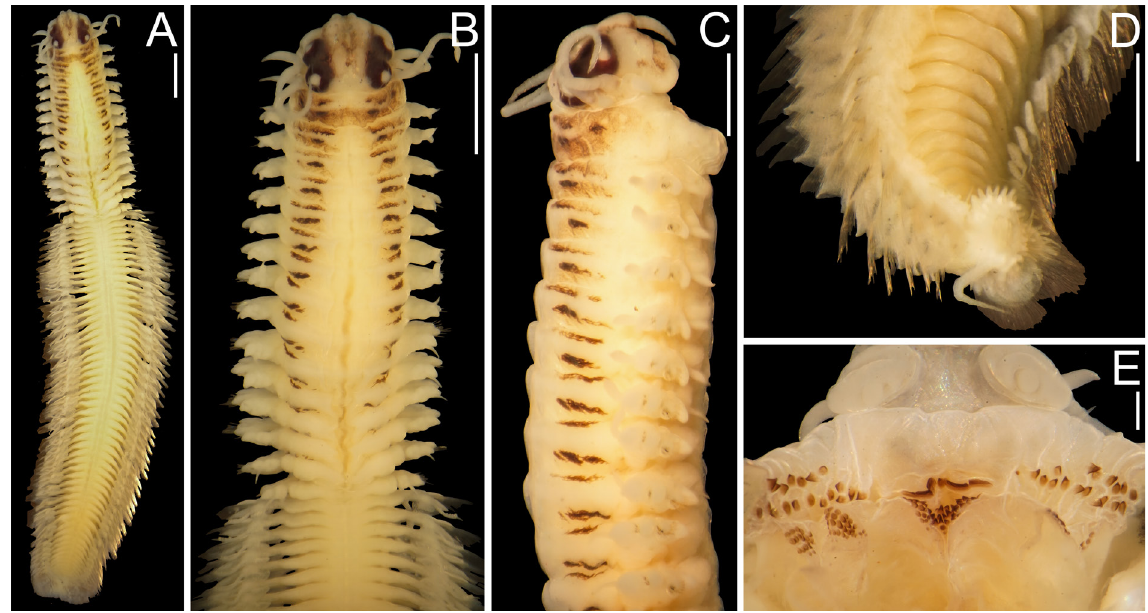
Fig. 5. Perinereis bairdii (Webster, 1884). Topotype male (USNM 1480197). A . Whole specimen, dorsal view. B . Anterior end, dorsal view. C . Same, lateral view. D . Posterior end, dorsal view. E . Pharynx dissected, ventral view. Scale bars: A–B = 1 mm; C = 0.5 mm; E = 0.2